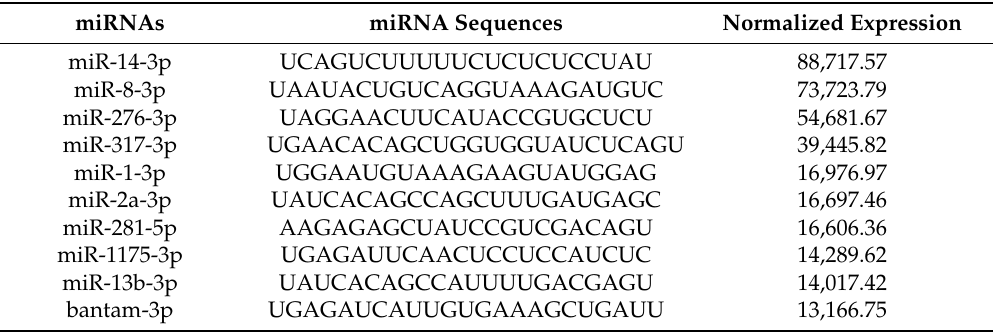
Table 2. miRNAs strongly expressed in L. decemlineata .